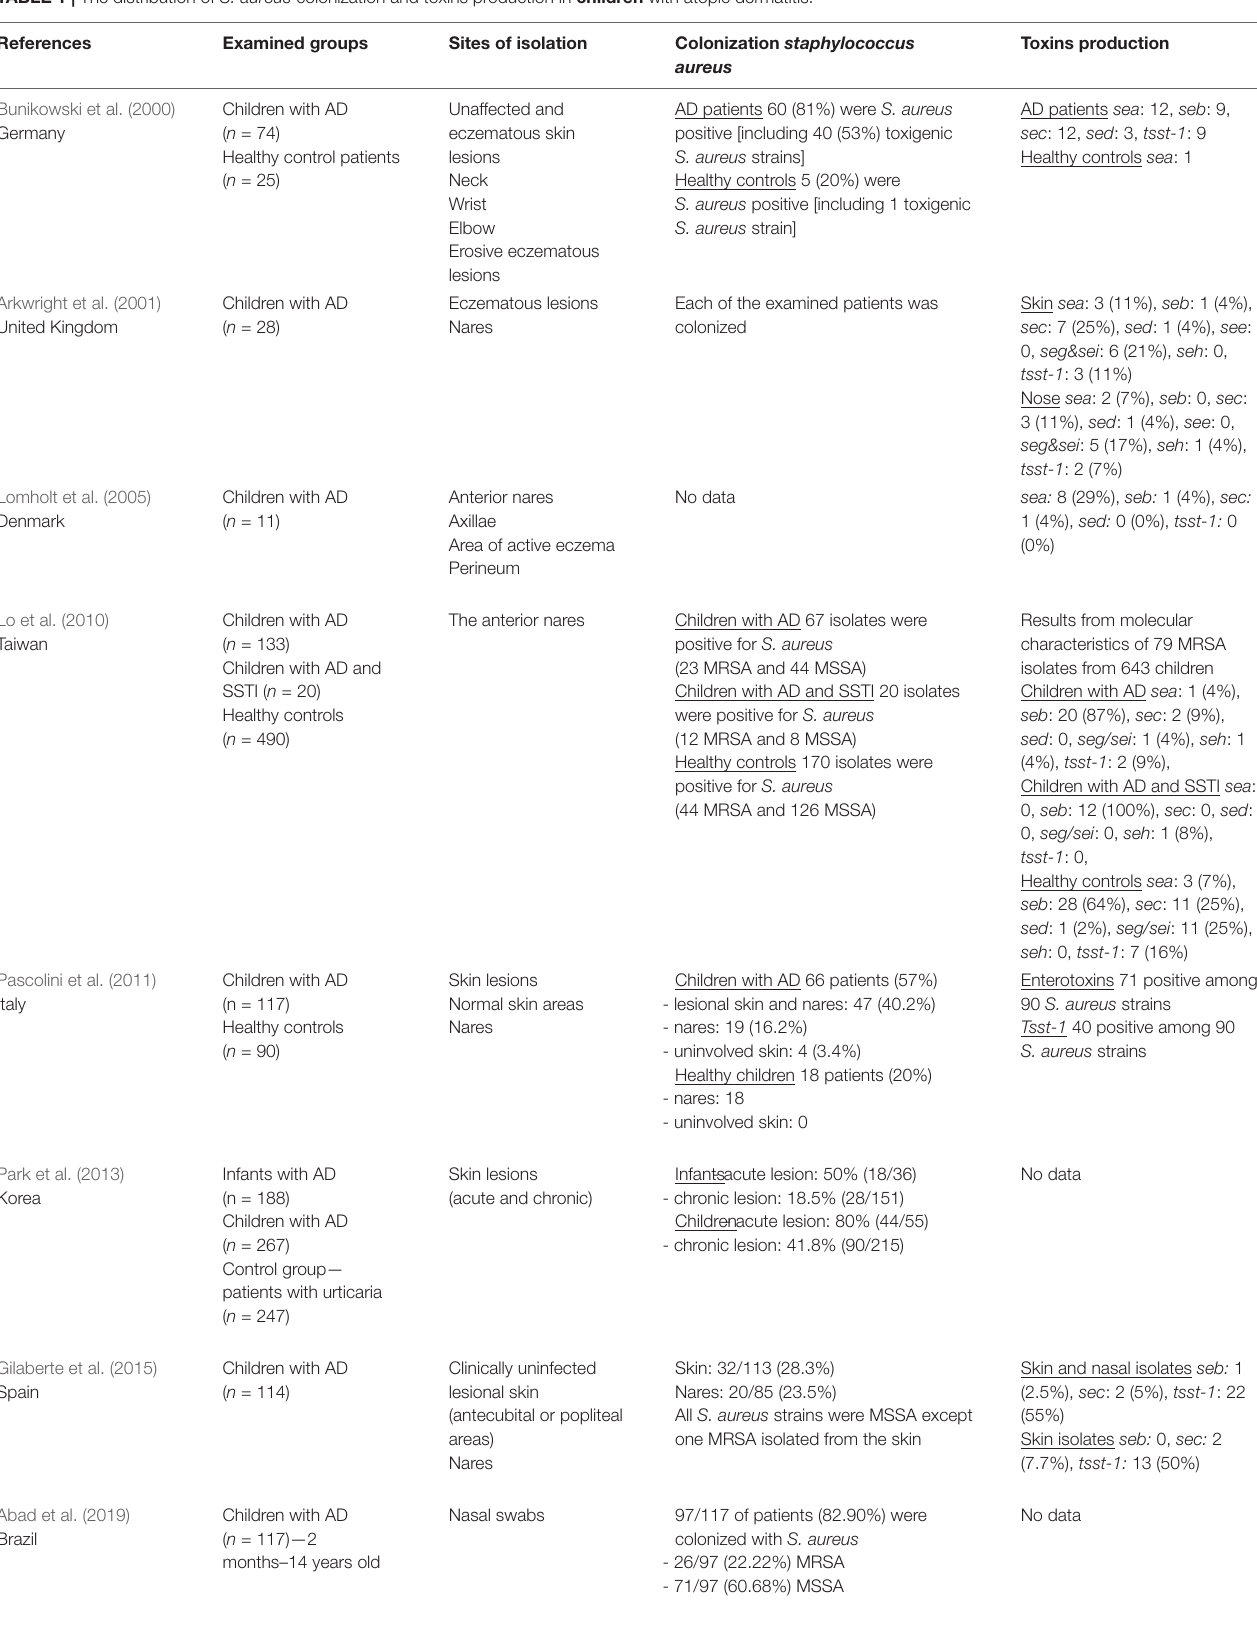
TABLE 1 | The distribution of S. aureus colonization and toxins production in children with atopic